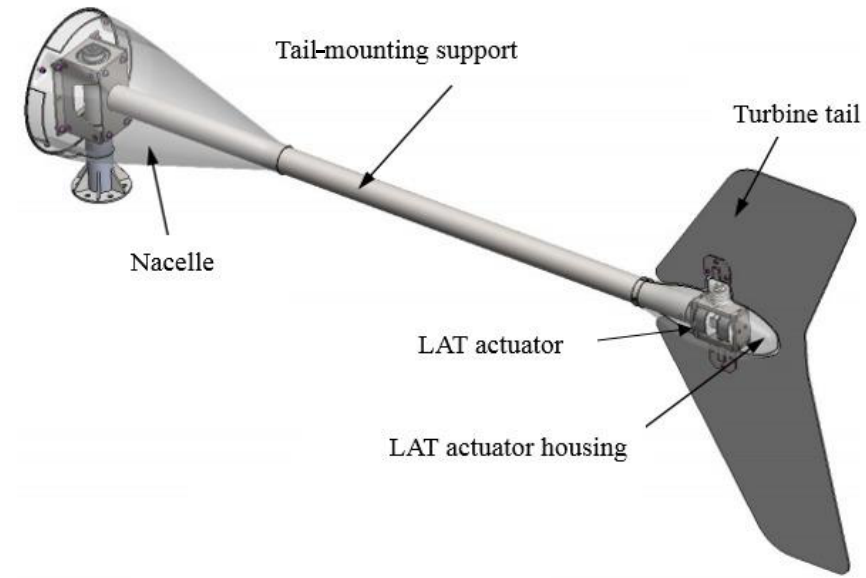
Figure 2. LAT actuator placement in the wind turbine assembly.